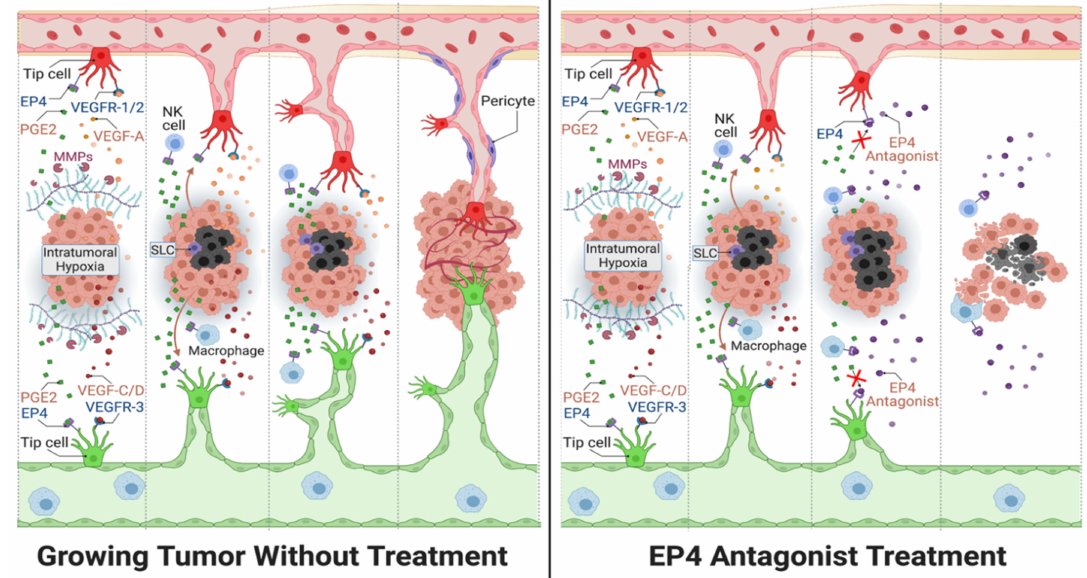
Figure 8. General outline for the action of EP4 antagonists used in breast cancer treatment ( right panel) compared to conditions of no treatment ( left panel). The diagram includes the interaction of EP4 agonist PGE2 with EP4 receptors on sprouting endothelial cells (tip cells), natural killer (NK) cells and macrophages, along with VEGFs binding to VEGF receptors (VEGFRs) located on the tip cells of newly formed lymphatics (green) and blood vessels (red). VEGFs are released by hypoxia induction within the tumor core (black cells). Also, the presence of matrix metalloproteases (MMPs) enhances tip cell invasion into the extracellular matrix to complete vasculature. The right panel demonstrates how EP4-antagonist treatment abrogates both angiogenesis and lymphangiogenesis. Furthermore, EP4 antagonist treatment prevents the stimulation of cancer stem-like cells (SLCs) in breast cancer. Lastly, antagonizing EP4 receptors located on various immune cells (NK cell and macrophages) allow an enhanced anti-tumor immune